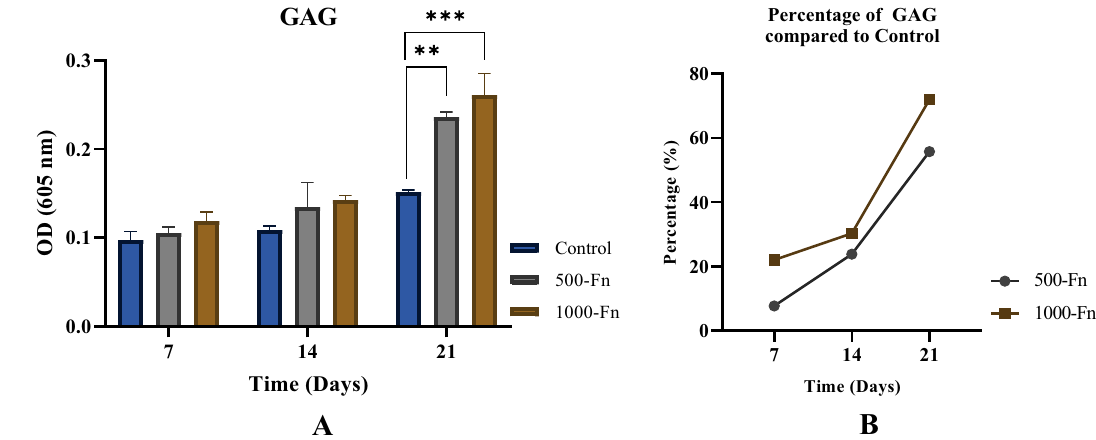
Figure 8. GAG accumulation of hWJ-MSCs grown on fibronectin micropattern ( A ) and percentage of GAG increased ( B ) on fibronectin (Fn) micropattern compared to control after 7, 14, and 21 days of culture